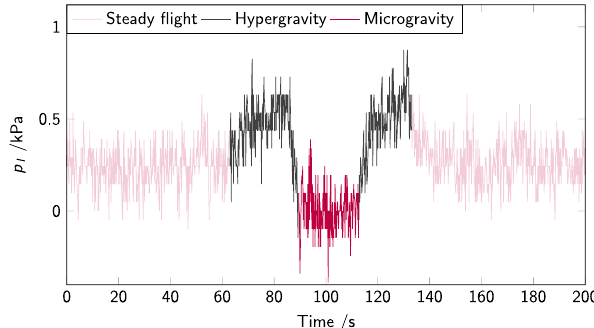
Fig. 6 Pressure p l on the bottom sensor inside a cell fi lled with powder, but where the piston does not move: the pressure changes are solely due to changes in acceleration during the parabolic fl ight maneuvers. Initial time t = 0 s is not a signi fi cant